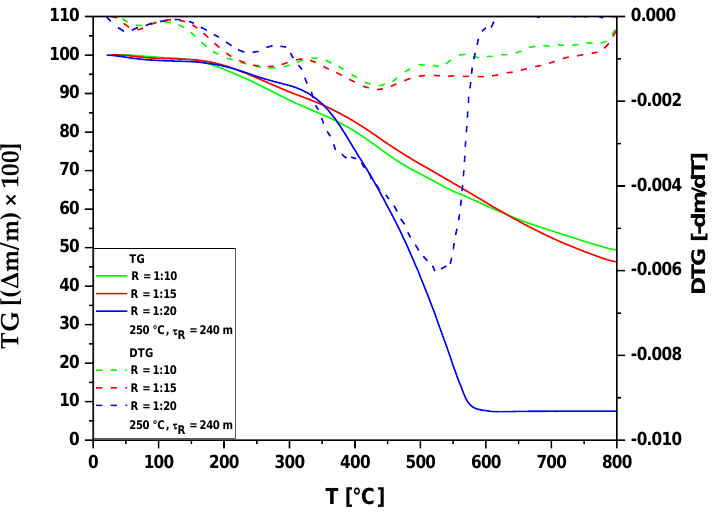
Figure 5. TG–DTG curves (under inert N 2 atmosphere) of hydro-chars obtained using biomass/H 2 O ratios of 1:10, 1:15 and 1:20 at 250 °C.